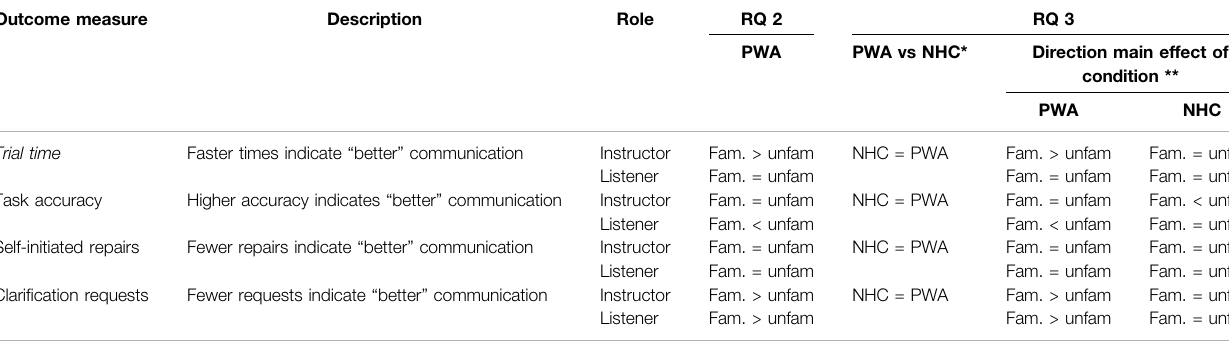
TABLE 5 | Results for research questions two and three by outcome measure. Outcome measure